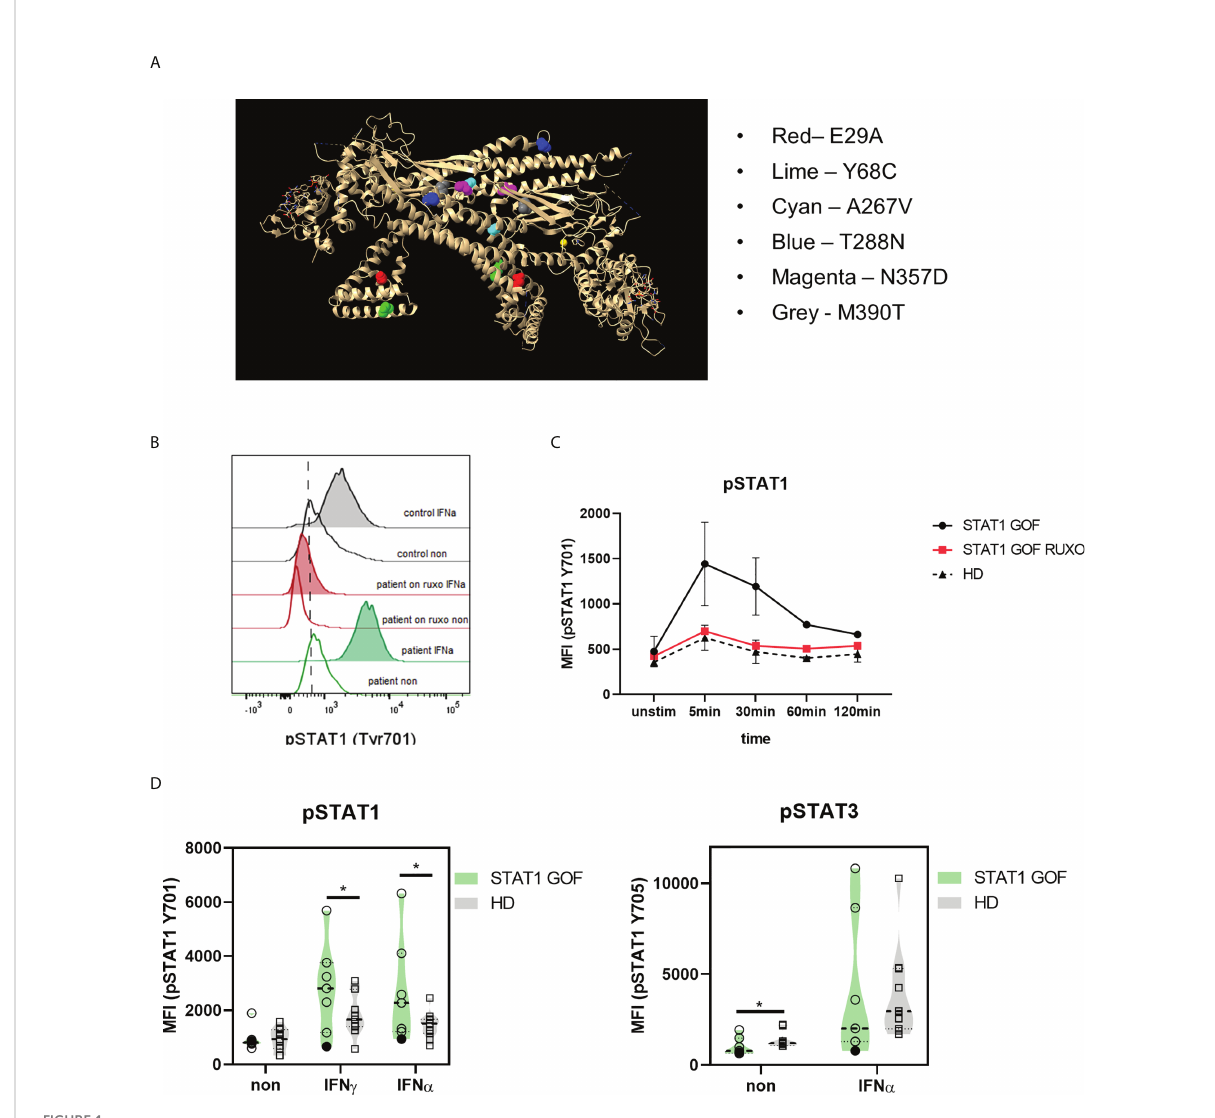
FIGURE 1 STAT1 mutations in the patient cohort. (A) STAT1 mutations in the 3D dimeric protein structure; the position of each mutation is highlighted (B) Representative histogram of STAT1 phosphorylation (Tyr701) upon IFN a stimulation in STAT1 GOF and HDs ’ monocytesdetected by fl ow cytometry (C) Kinetics of STAT1 and STAT3 phosphorylation (Tyr701) upon IFN a stimulation in STAT1 GOF (n = 3) and HDs ’ monocytes (n = 4) detected by fl ow cytometry (D) Phosphorylation of STAT1 (pSTAT1; Tyr701) and STAT3 (pSTAT3; Tyr705) upon IFN g and IFN a stimulation in STAT1 GOF (n = 7) and HDs ’ monocytes (n = 11) detected by fl ow cytometry HD - healthy donors; Tyr - tyrosine. Values are standardized and expressed as median values. Statistical analyses were performed using paired t-tests. Values of p<0.05 (*), p<0.01 were considered statistically signi fi